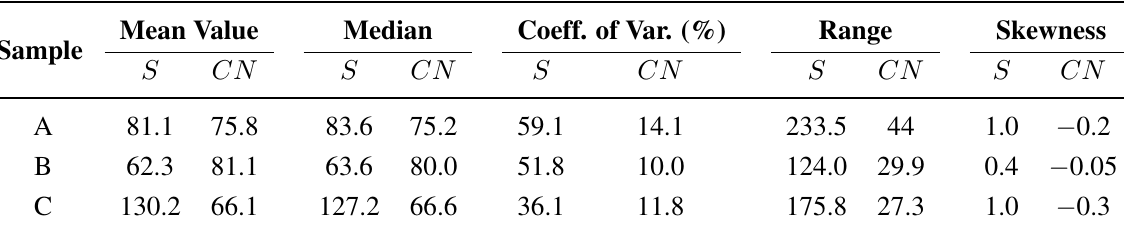
Table 1. Basic characteristics of Samples A, B and